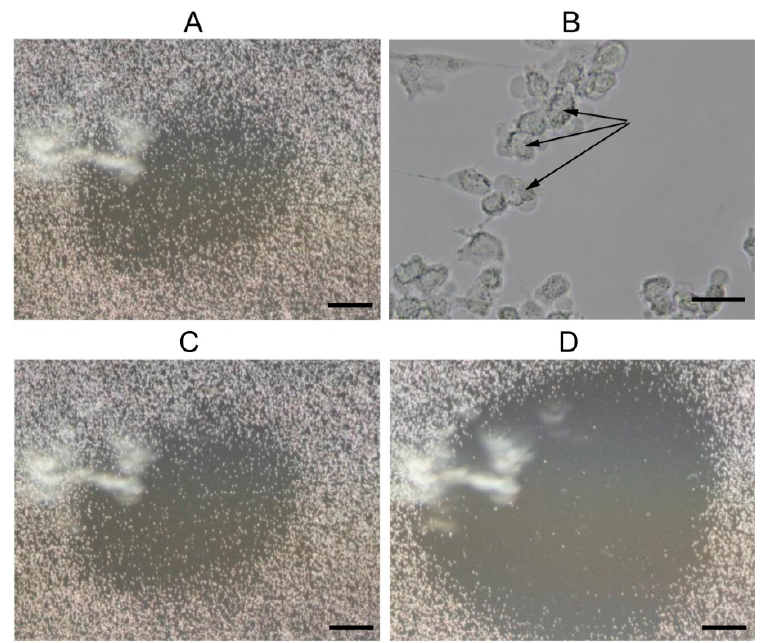
Figure 4. Micrographs of a BMSC culture 1 ( A , B ), 24 ( C ) and 36 ( D ) hours after exposure to LTP. Microphotographs were taken at the location of the needle electrode, on which the plasma formation process took place. The scale bars were 500 μ M ( A , C , D ) and 40 μ M ( B ). Black arrows indicate vesiculation of the cytoplasmic membrane.